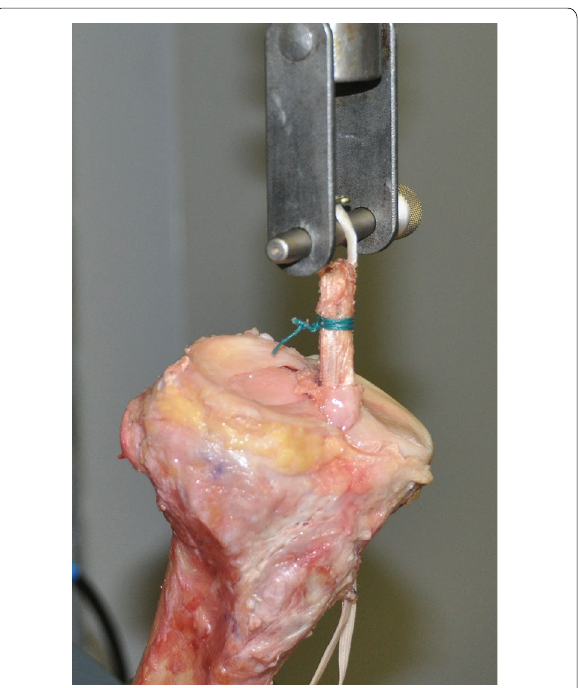
Fig. 4 Quadruple semitendinosus tape construct in testing